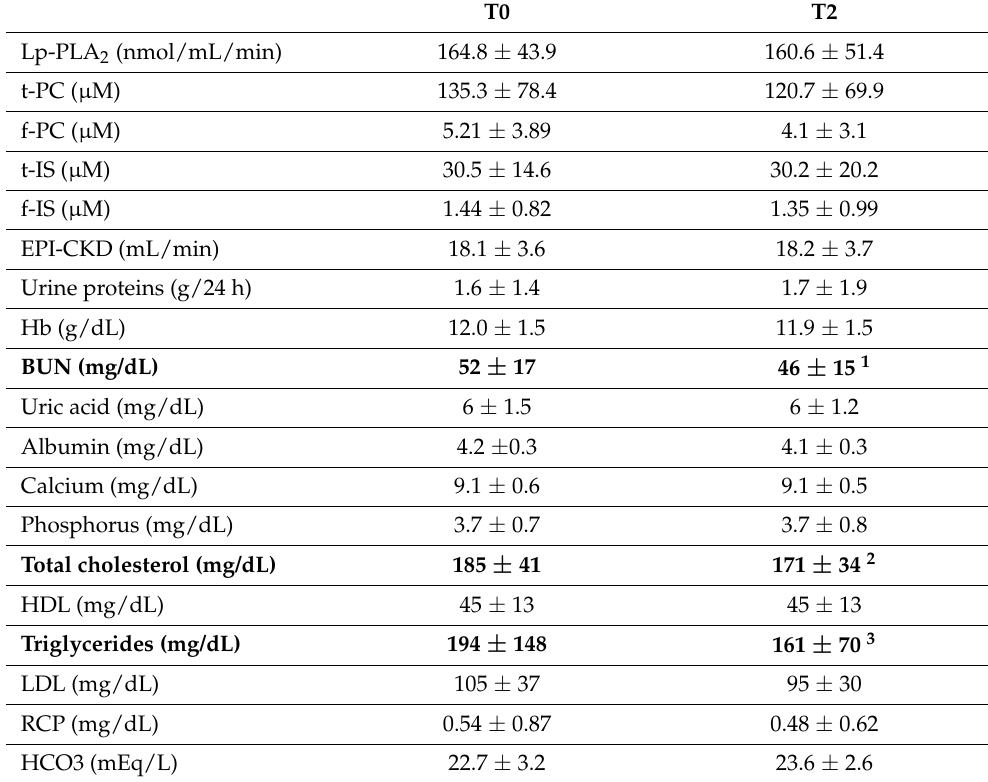
Table 2. Comparison between biochemical parameters and pharmacological therapy in all patients. Values are presented as mean ±